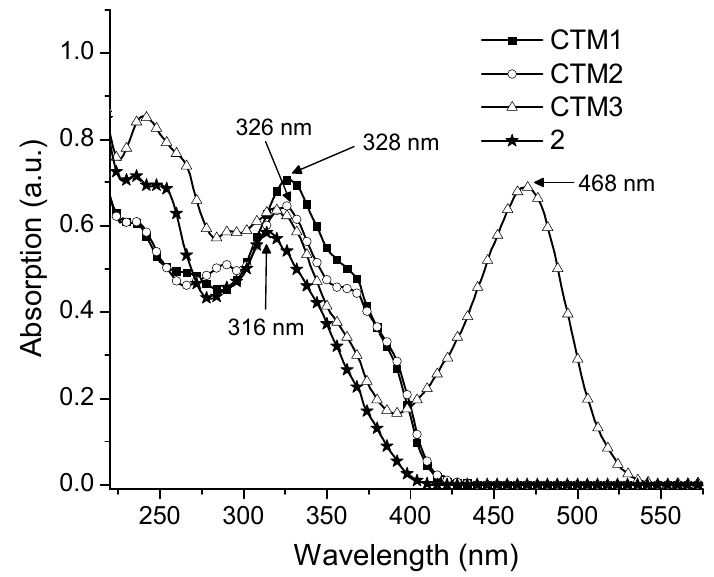
Figure 2. UV/Vis absorption spectra of 10 − 4 M THF solutions of CTM1 – 3 and 2